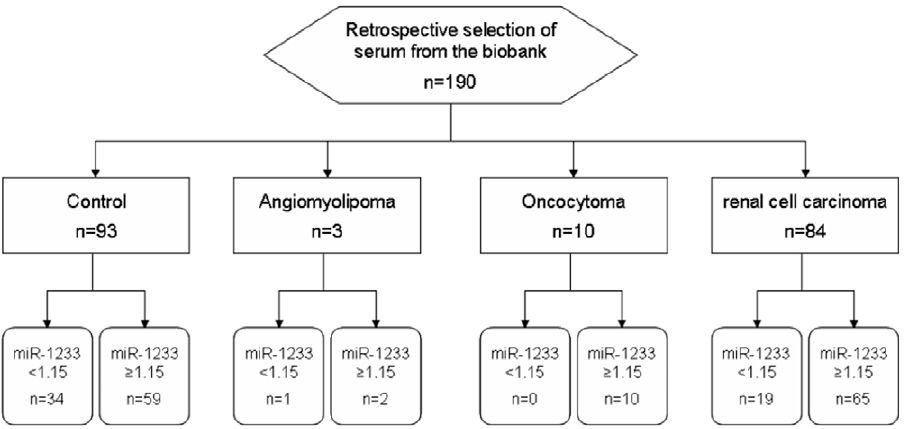
Figure 1. Flow Chart: Verification of miR-1233 as diagnostic marker of renal cell carcinoma.